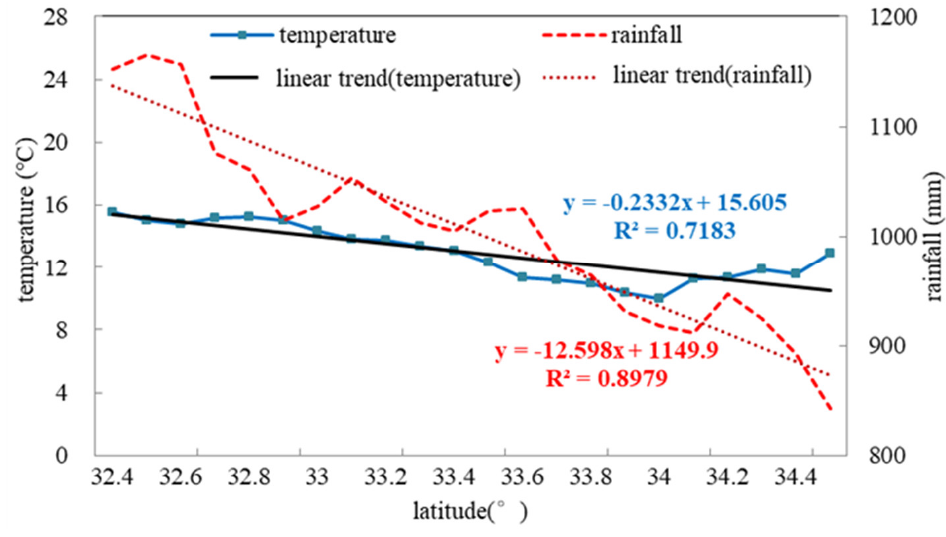
Figure 11. As in Figure 9, but for latitude in the QMs.